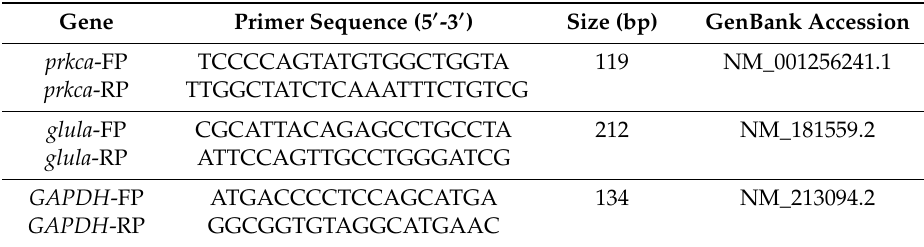
Table 2. Primers used for real-time